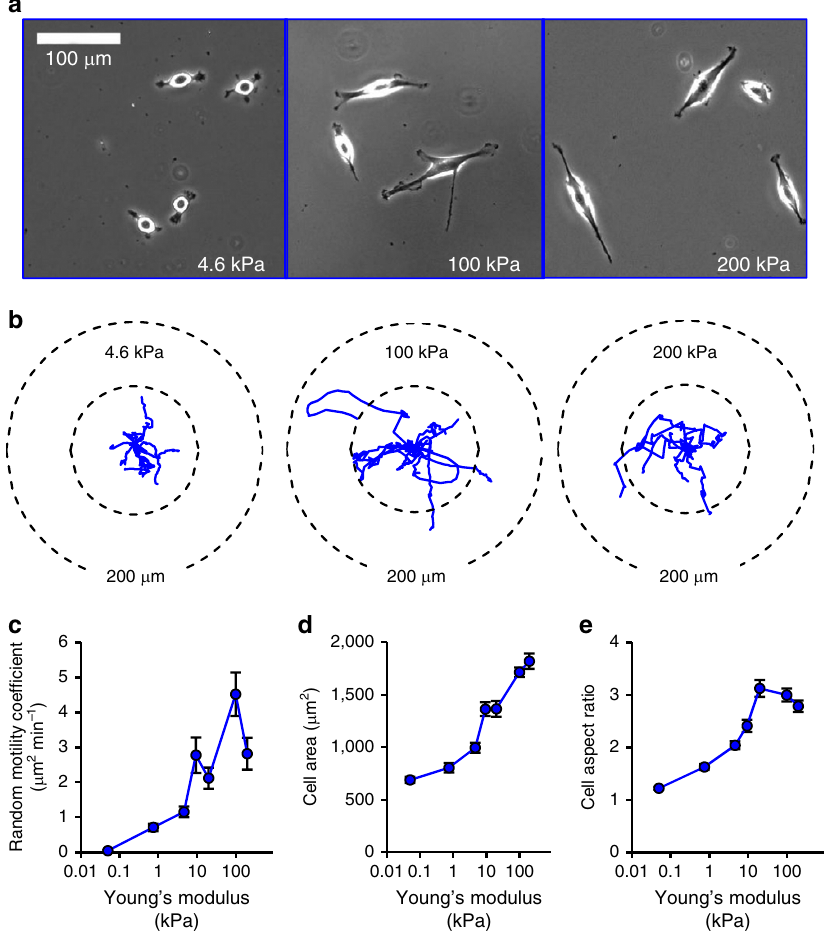
Figure 2 | U251 glioma cell migration and morphology have maxima with respect to substrate Young’s modulus. ( a ) Representative images of U251 glioma cells on 4.6, 100 and 200kPa Young’s moduli polyacrylamide gels. ( b ) Wind-rose plots of cell trajectories on 4.6, 100 and 200kPa. Ten randomly selected cell trajectories over 10h are shown for each condition. ( c ) Cell random motility coefficient has a maximum between 20 and 200kPa ( P ¼ 0.04). ( d ) Projected cell area has a potential maximum at B 200kPa or higher. ( e ) Cell aspect ratio has a potential maximum at B 9kPa. All error bars are s.e.m. The number of observations for each experiment can be found in Supplementary Table